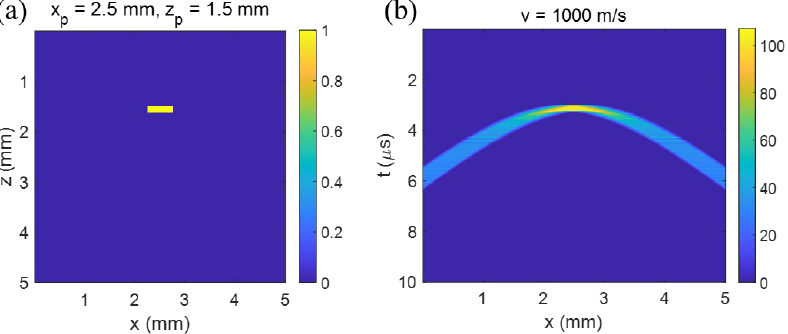
Figure 3. Simulation of LUS B-scan imaging. ( a ) The cross-sectional view of the target object. It is a line along y -axis but a uniform box in x-z plane. ( b ) The simulated B-scan image of the object in ( a ).